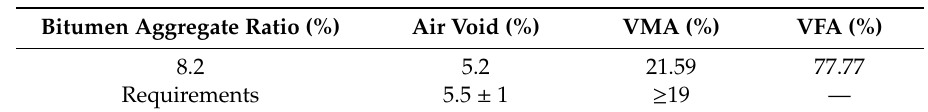
Figure 4. Gradation curves of the CRMB mixture. Table 12. Volume indexes of gradation B.